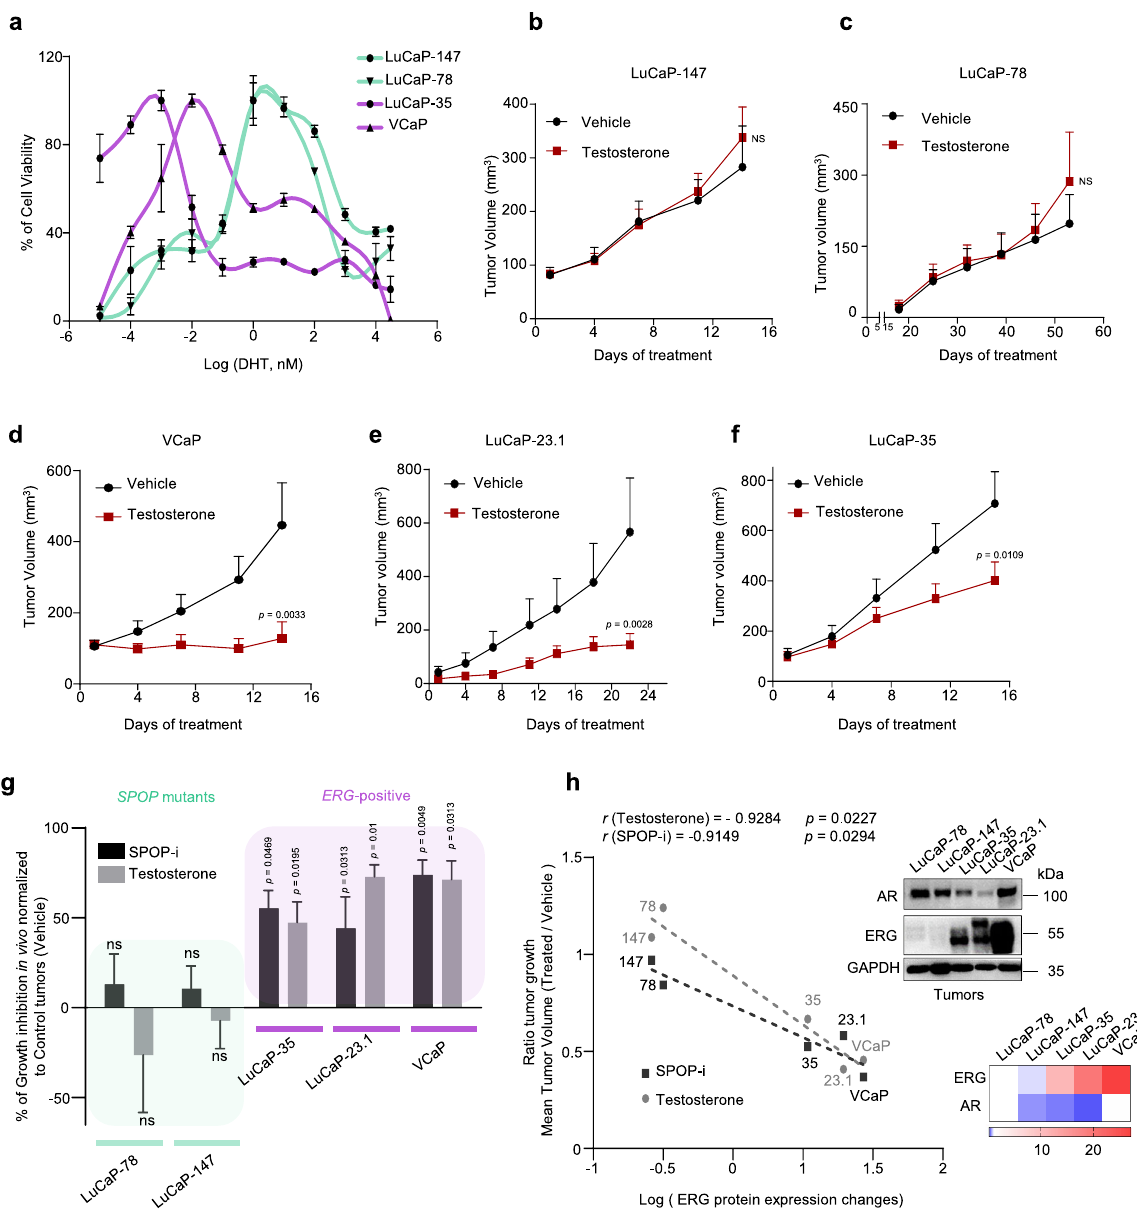
Fig. 8 ERG and mutant SPOP trigger different responses to therapeutic interventions. a Dose – response curve to DHT treatment of VCaP, LuCaP-35, LuCaP-78, and LuCaP-147 PDX cancer cells. Before DHT treatment, PDX were grown in standard media without DHT. VCaP were starved for 24 h in